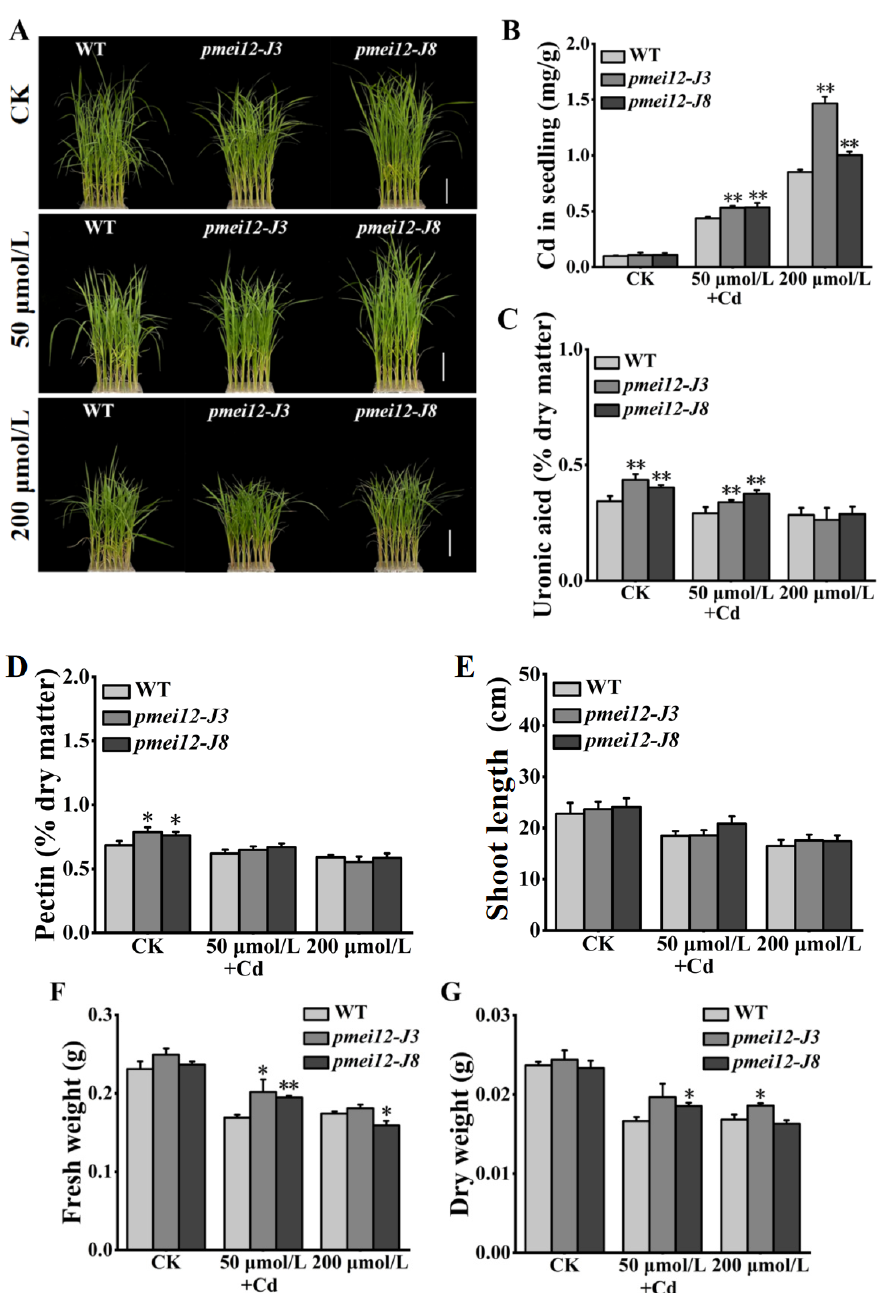
Figure 8. Seedlings treated with heavy metal Cd stress. ( A ) Plants of pmei12 and WT under Cd treatments; ( B ) Cd content of seedlings (mg/g); ( C ) Uronic acid content in seedlings (dry matter); ( D ) Pectin content in seedlings (dry matter); ( E ) Shoot length (cm); ( F ) Fresh weight of seedlings; ( G ) Dry weight of seedlings. * and ** indicate the significant difference between pmei12 lines and WT by t -test at p < 0.05 and 0.01, respectively. Scale bars: ( A ) 5 cm (n = 3).